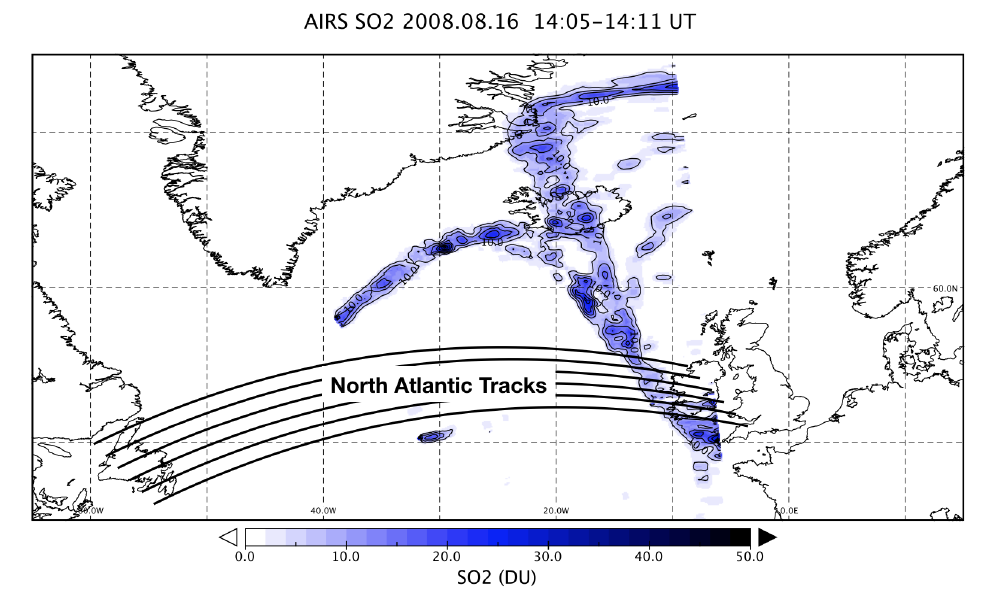
Figure 23. AIRS SO 2 retrieval for 16 August 2008 for two granules when strong meridional flow is drawing the SO 2 plume southwards near to the location of the